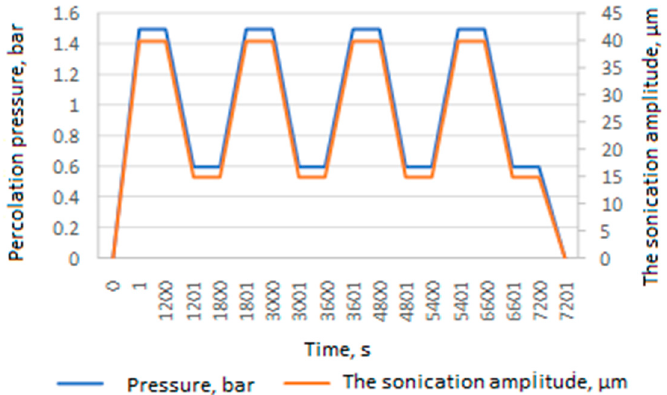
Figure 9. Diagram of the hybrid extraction process: percolation (compressed air)–ultrasonication (ultrasonic field generation).